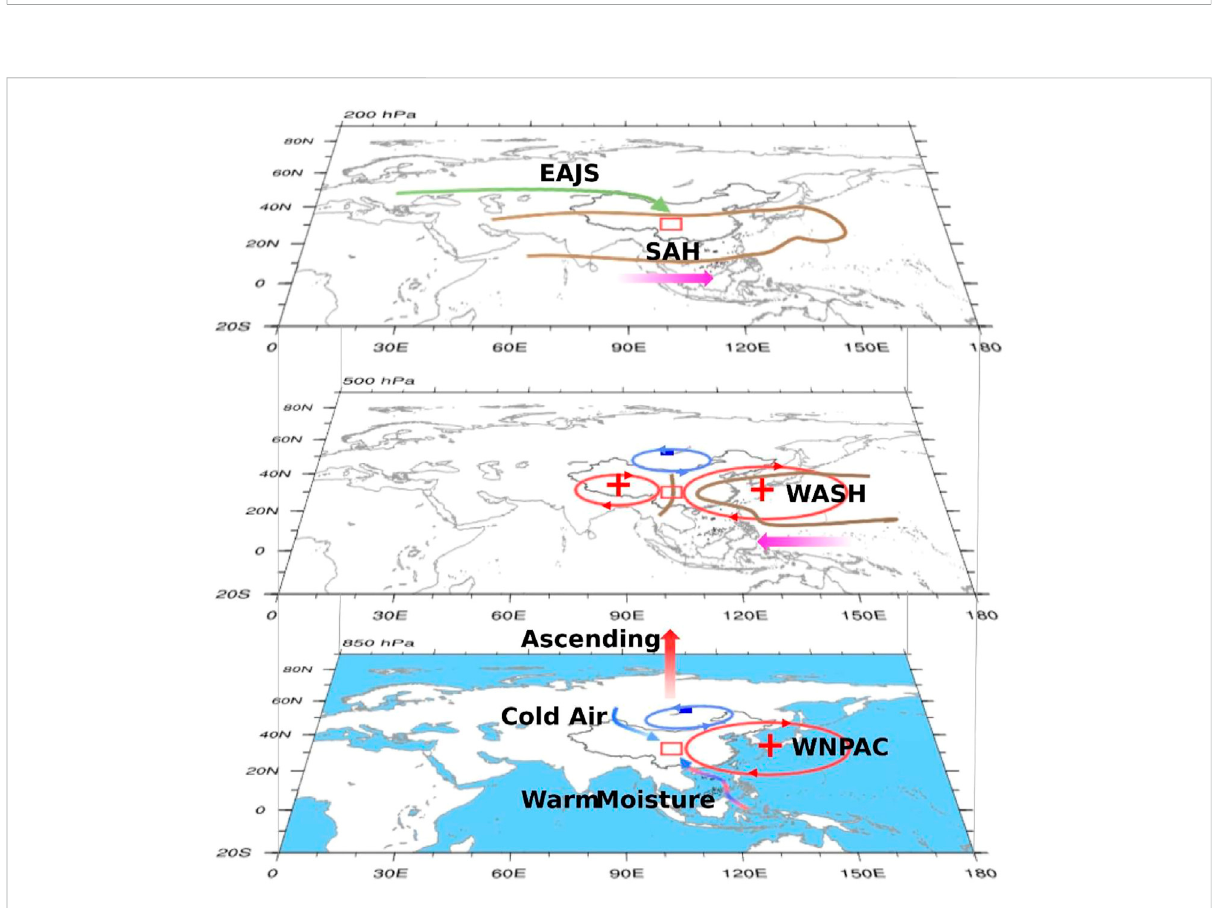
FIGURE 9 Schematic diagram describing what drives the anomalous strong precipitation over WC in August